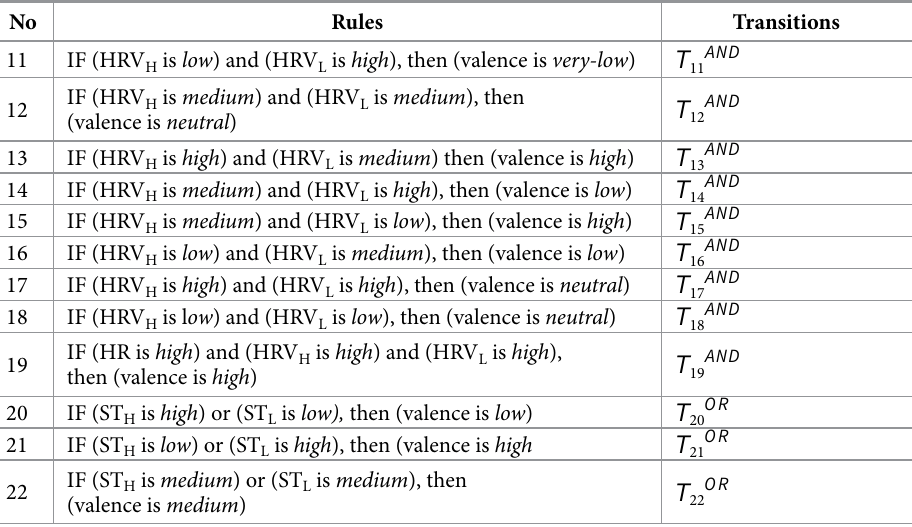
Table 3. Set of rules and corresponding transitions of logical Petri nets of transforming of the arousal- valence space Rules